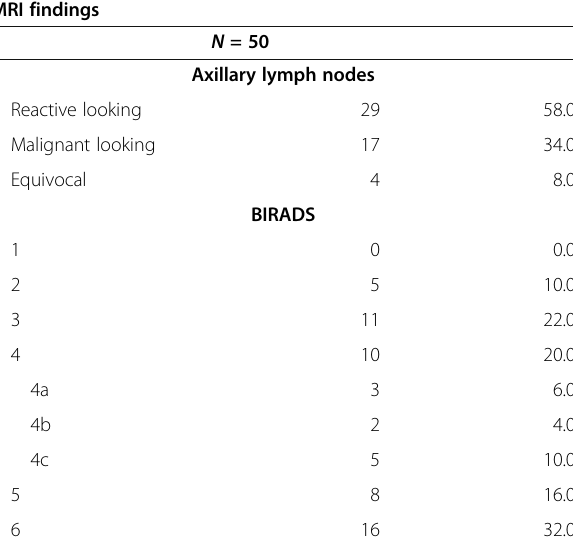
Table 2 Distribution of the studied cases according to CE-MRI findings ( N = 50)